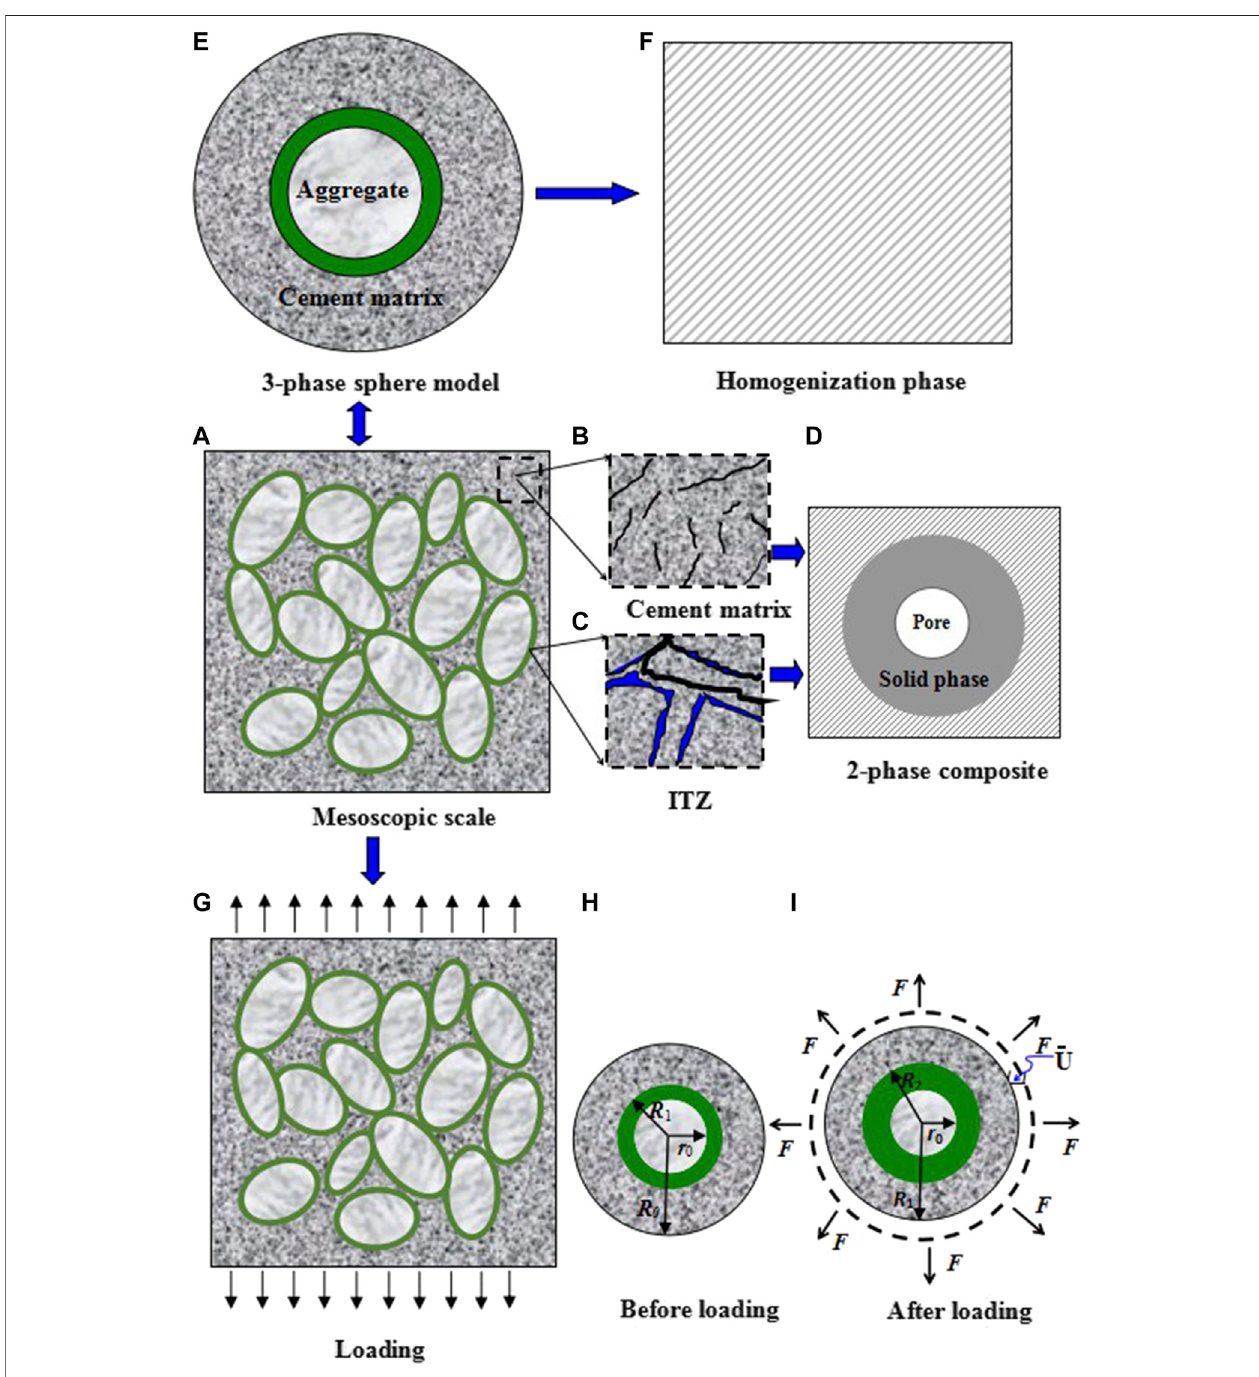
FIGURE 1 | Diagram of multi-scale in concrete under